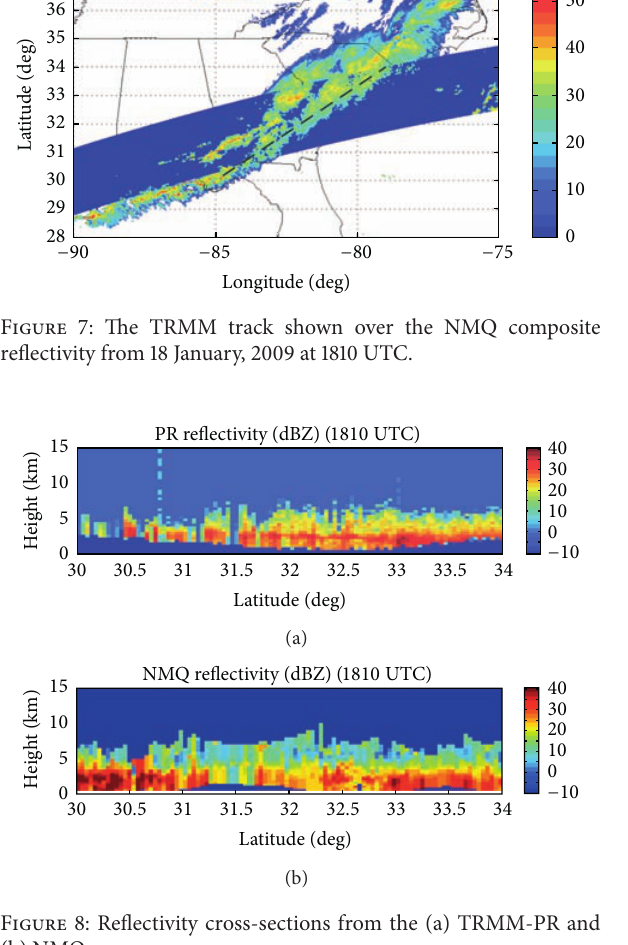
Figure 8: Reflectivity cross-sections from the (a) TRMM-PR and (b) NMQ.